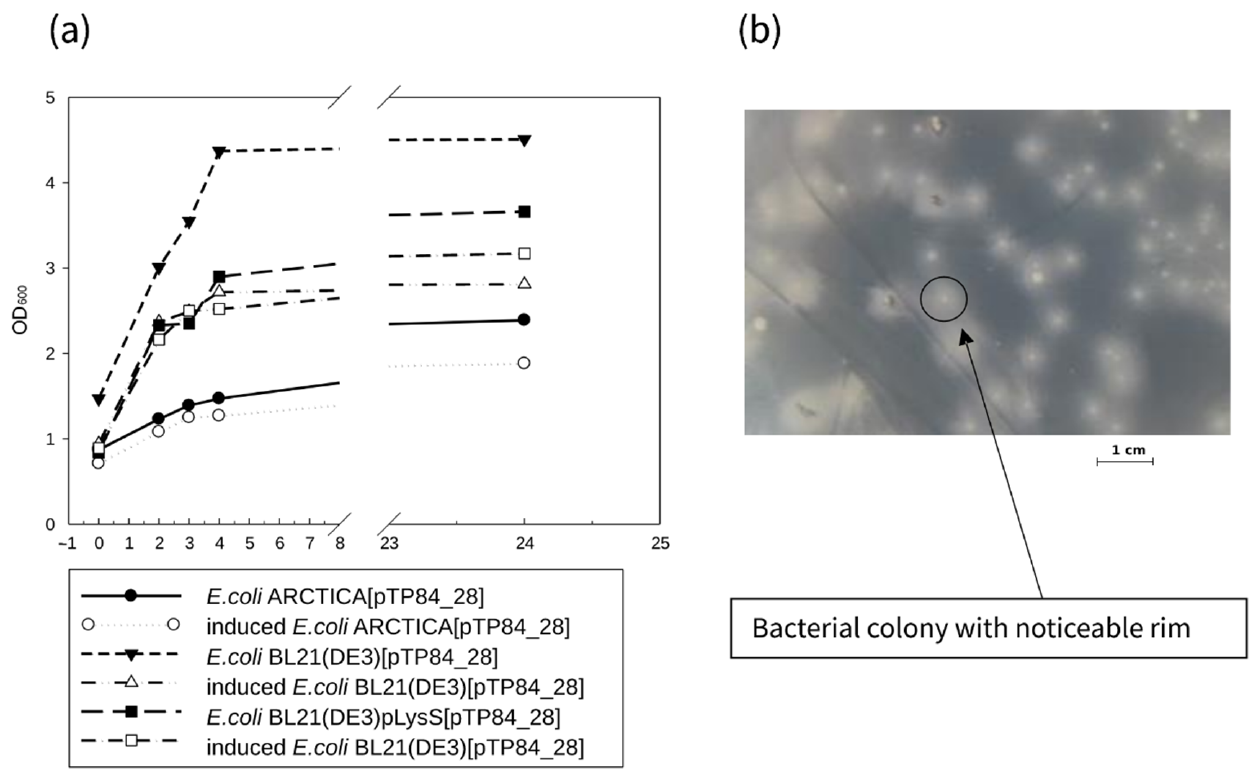
Figure 1. Expression of recombinant TP84_28 gene in three different E. coli cells. ( a ) Growth curves of bacterial clones, carrying recombinant pTP84_28 plasmids containing the TP84_28 gene in various E. coli expression strains: BL21(DE3), BL21(DE3) (pLysS), and ARCTICA. ( b ) E. coli BL21(DE3) (pTP84_28), grown on solid LB medium. Only this strain exhibited the characteristic rim around the bacterial colony, indicating interference of the cloned TP84_28 gene with the bacteria’s growth rate.